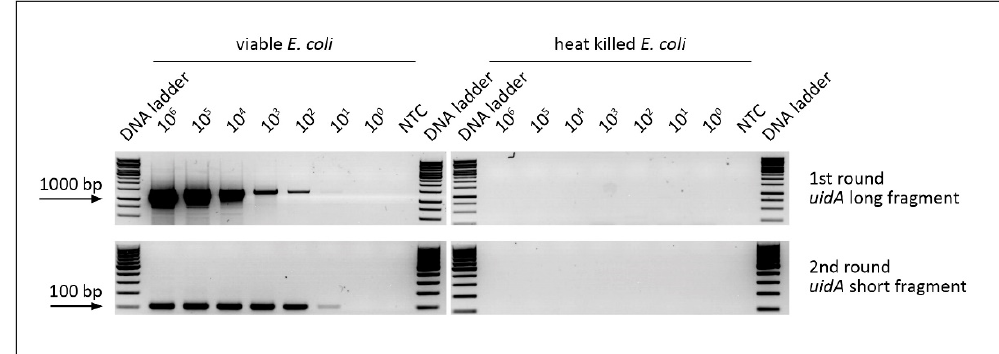
Figure 4. LOD tests applying direct viability nested PCR shown for viable and heat killed E. coli cells. Bacteria were treated with PMA, and DNA was subsequently amplified. PCR products from the first round ( uidA long fragment; 1.37 kb) served as templates for the second PCR round ( uidA short fragment; 96 bp). The No Template Control (NTC) for ensuring the purity of PCR reactions was also amplified by PCR. All PCR products were verified using analytical agarose gels.